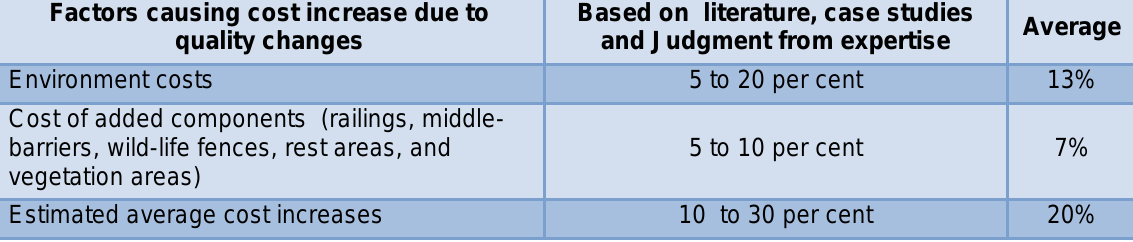
Table 3 Stylized quality changes between 1990 and